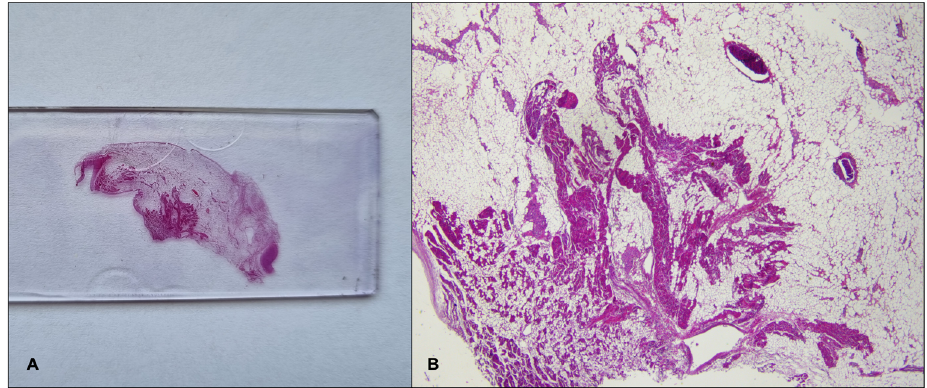
Figure 1. Gross histopathological examination (Hematoxylin and eosin) of the sino-atrial node on whole slide ( A ); ( B ) 1× magnification.